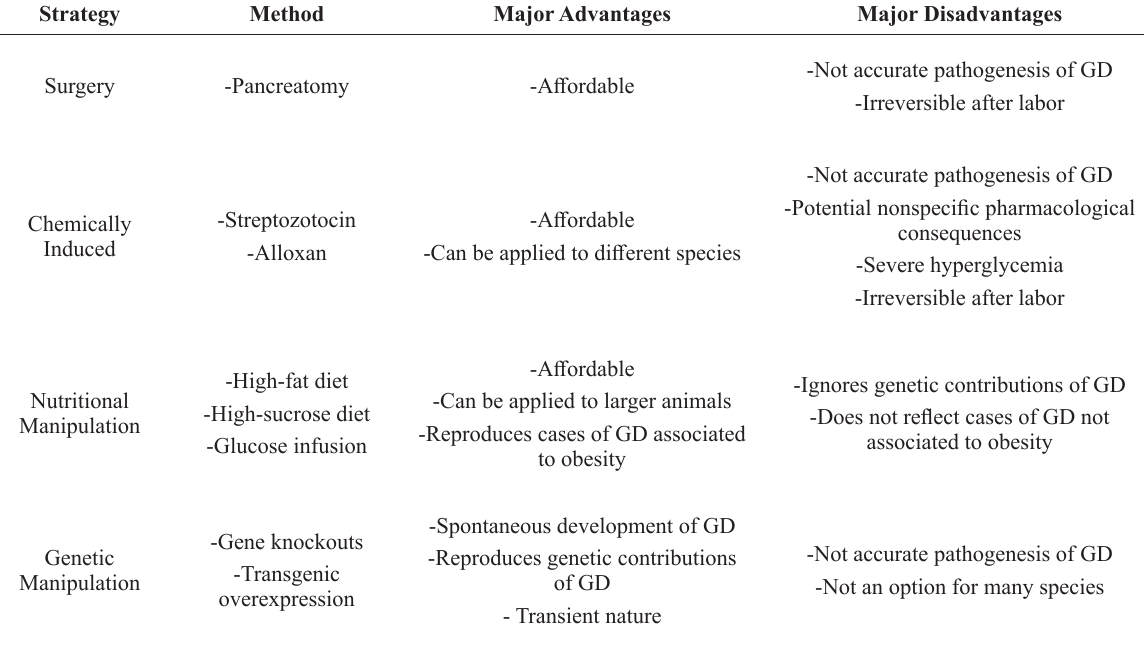
Advantages and disadvantages of currently available animal models of gestational diabetes.